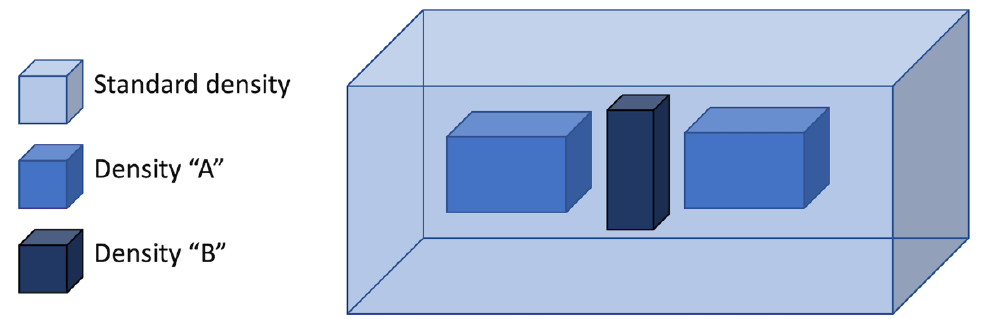
Figure 3. Examples of macroscale deterministic coding obtained by creating domains with different sizes, shapes and densities in a part produced by L-PBF. The different levels of porosity within each area are controlled through the laser energy density as proposed by Eisenbarth et al. [12].